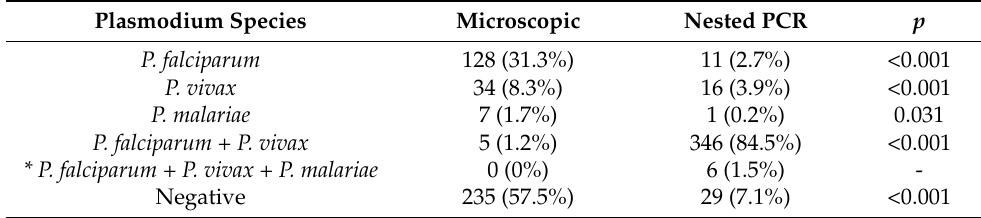
Table 3. Comparison of Plasmodium species identified by microscopic and molecular